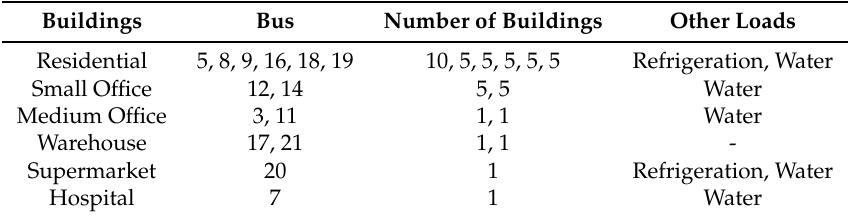
Table 1. Information of the buildings in the network.